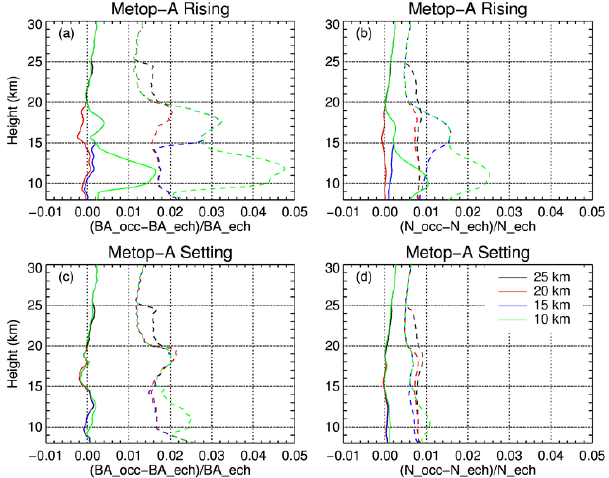
Figure 7. Similar to Fig. 5, except for the Metop rising (a, b) and setting (c, d) occultations, for all latitudes.